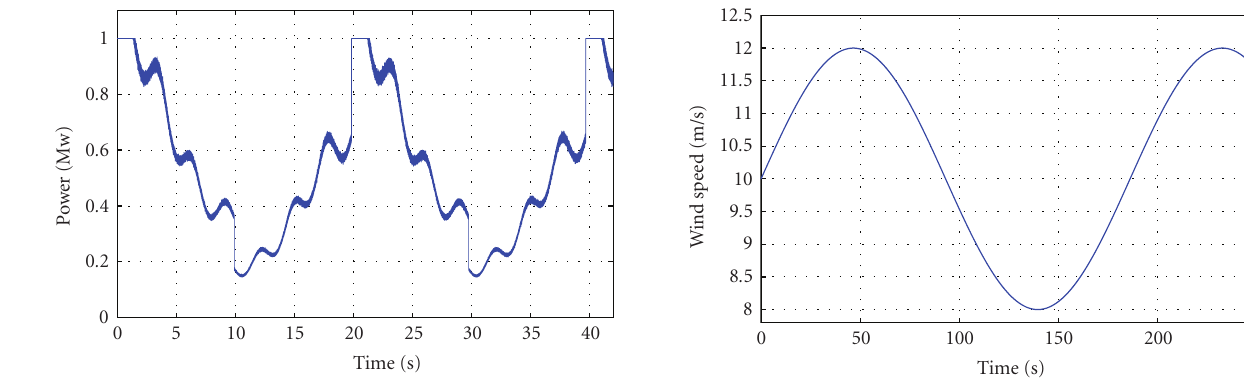
Figure 10: Wind speed.